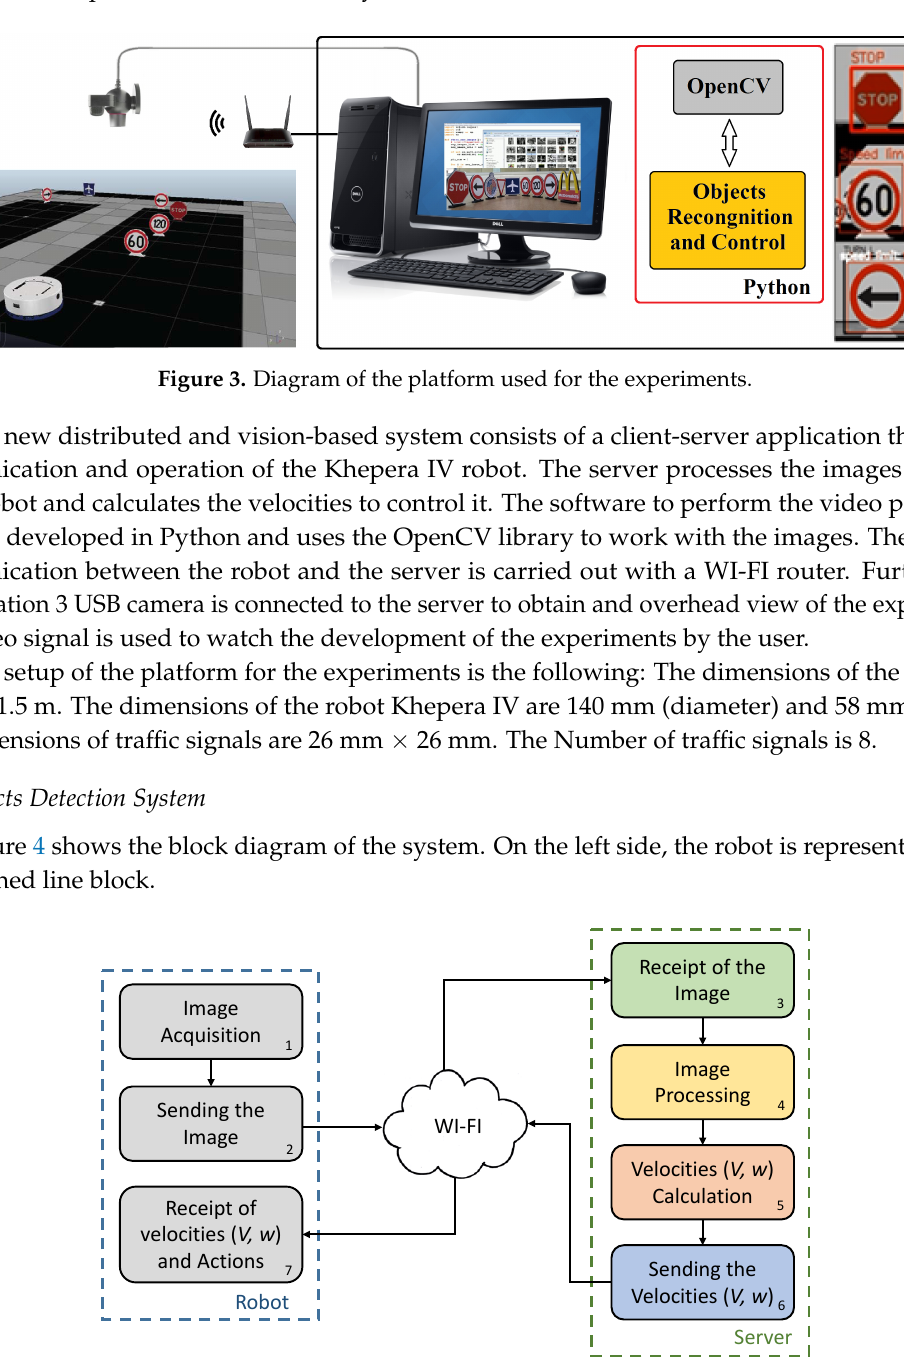
Figure 4. Block diagram of the